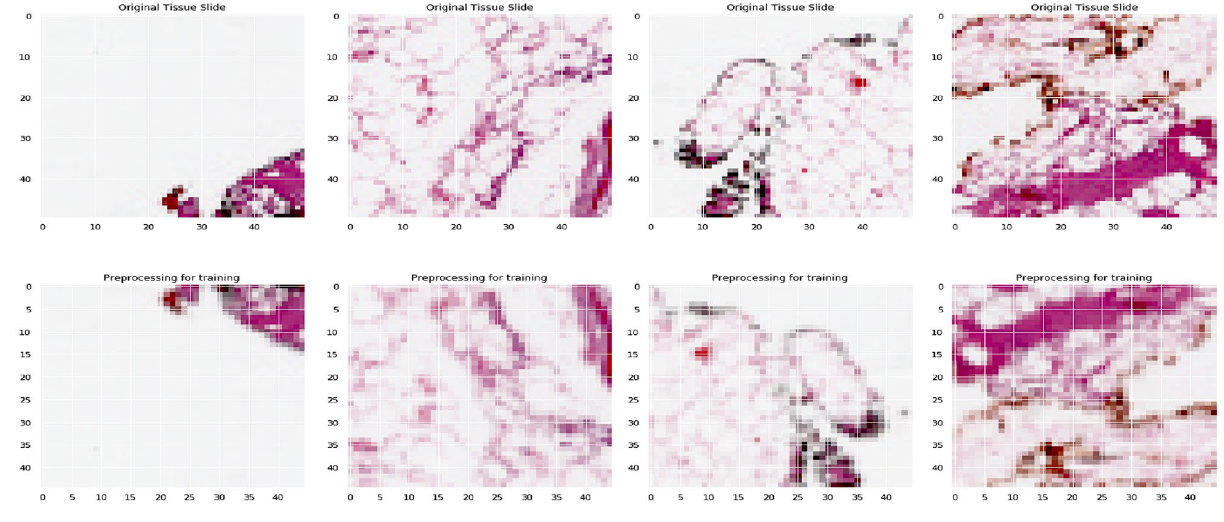
Figure 5. Processed image for training